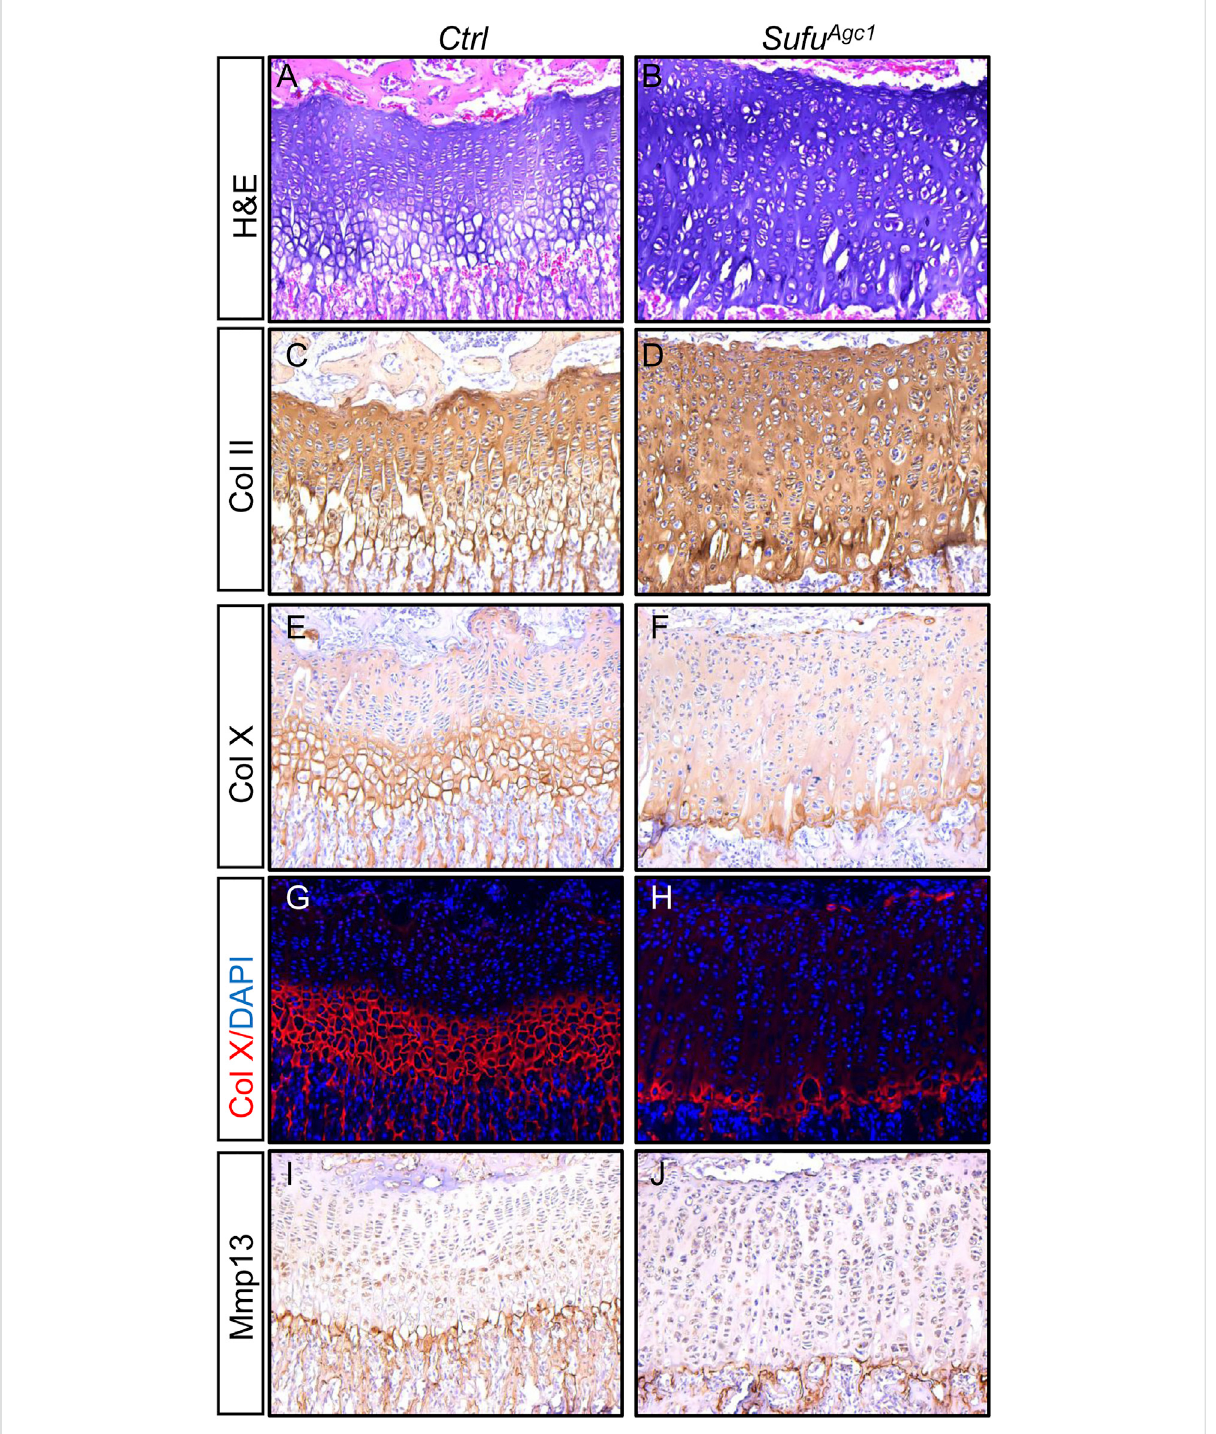
FIGURE 7 Chondrocyte-speci fi c deletion of Sufu in juvenile mice inhibited hypertrophic differentiation (A,B) H&E staining of the proximal tibial growth platesfromP30 Ctrl (A) and Sufu Agc1 mice (B)(C – F) Immunohistochemicalstainingofcollagentype Ⅱ (ColII) (C,D) andcollagentypeX(ColX) (E,F) on frozen sections of the proximal tibial growth plates from P30 Ctrl (C,E) and Sufu Agc1 (D,F) mice (G,H) Immuno fl uorescent staining of Col X on frozen sections of the proximal tibial growth plates from P30 Ctrl (G) and Sufu Agc1 (H) mice (I,J) Immunohistochemical staining of Mmp13 on frozen sections of the proximal tibial growth plates from P30 Ctrl (I) and Sufu Agc1 (J) mice. All mice were treated with 5 daily doses of tamoxifen starting at P14 and analyzed at indicate time.